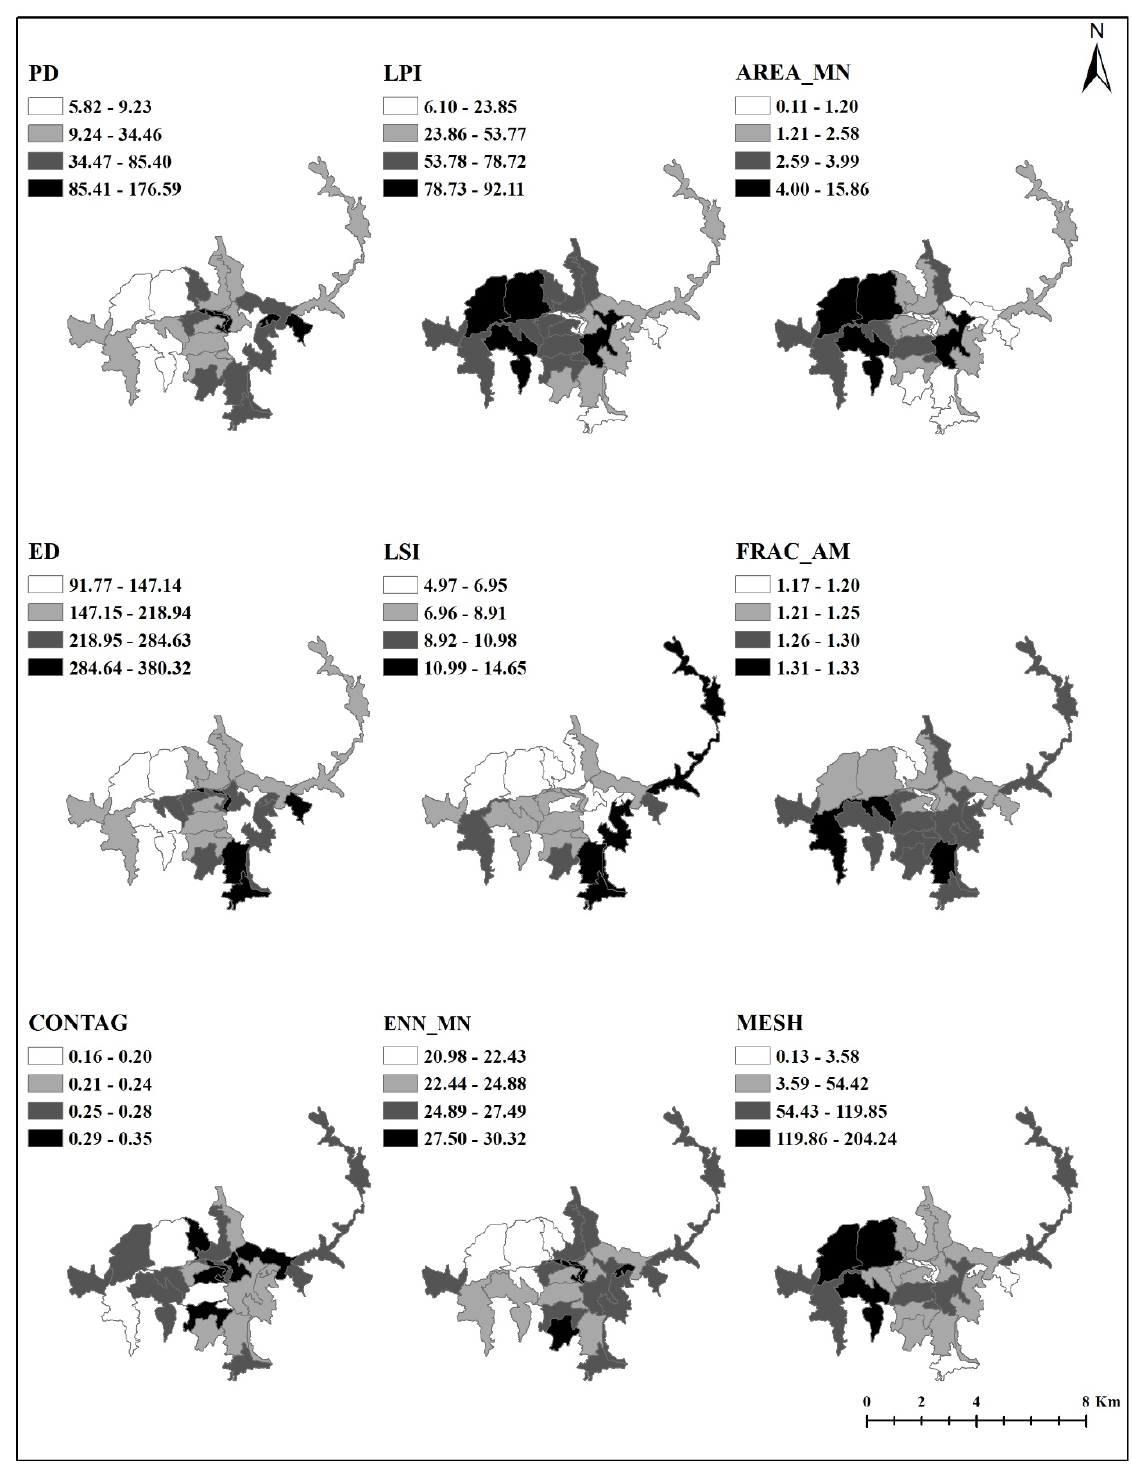
Figure 4. Spatial variation in landscape metrics by wards in Shimla.